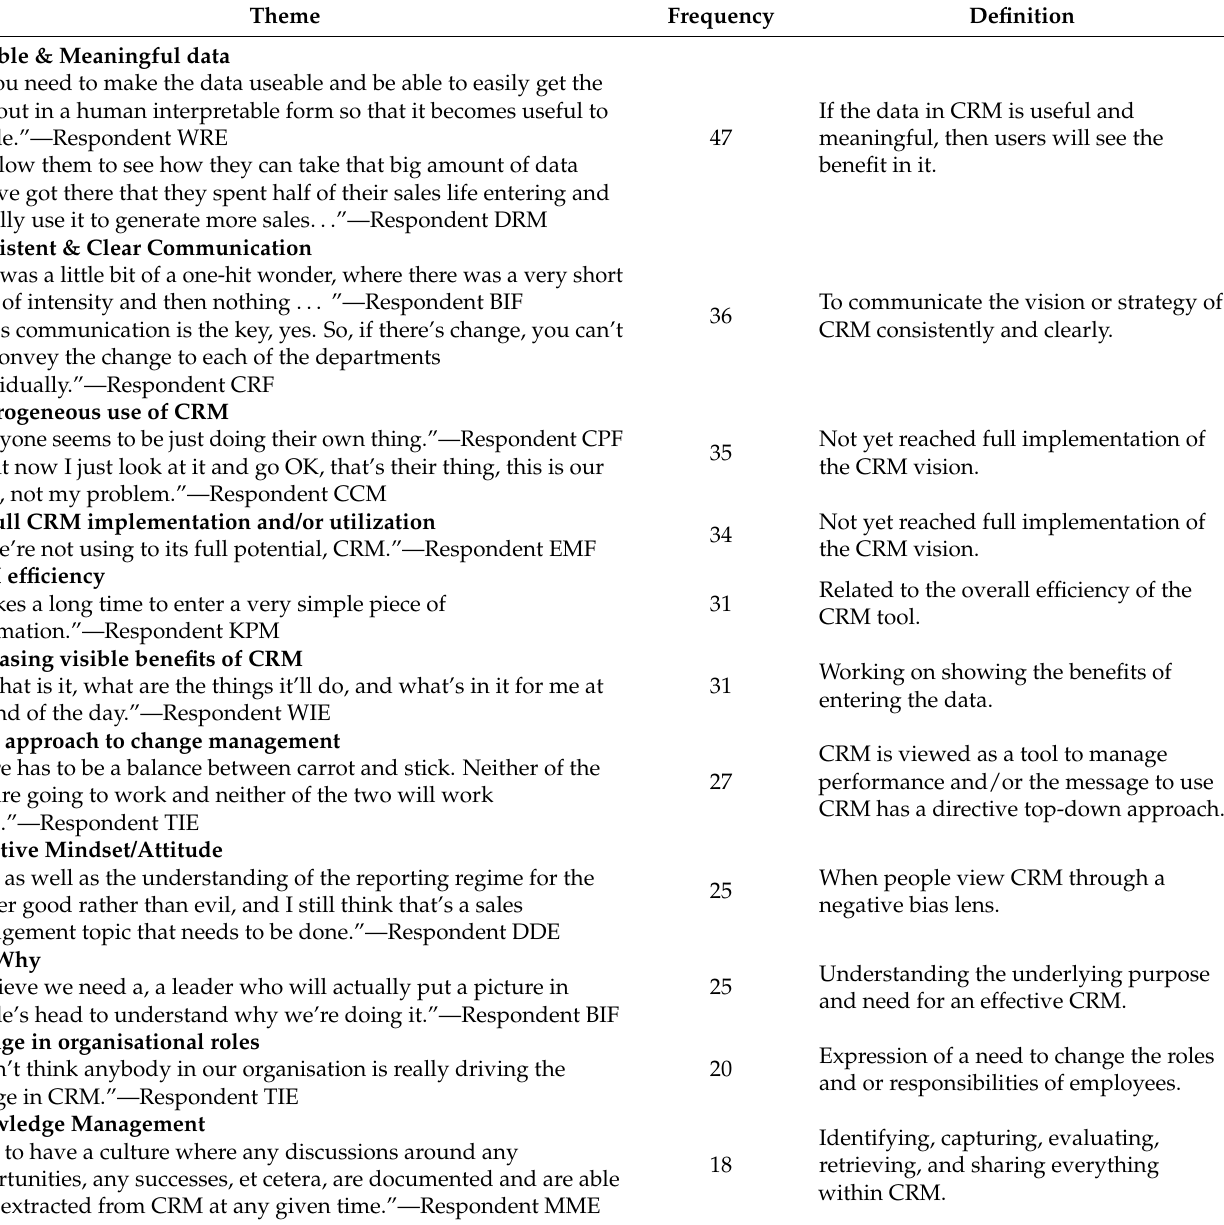
Table 2. Major themes created in the thematic analysis of semi-structured